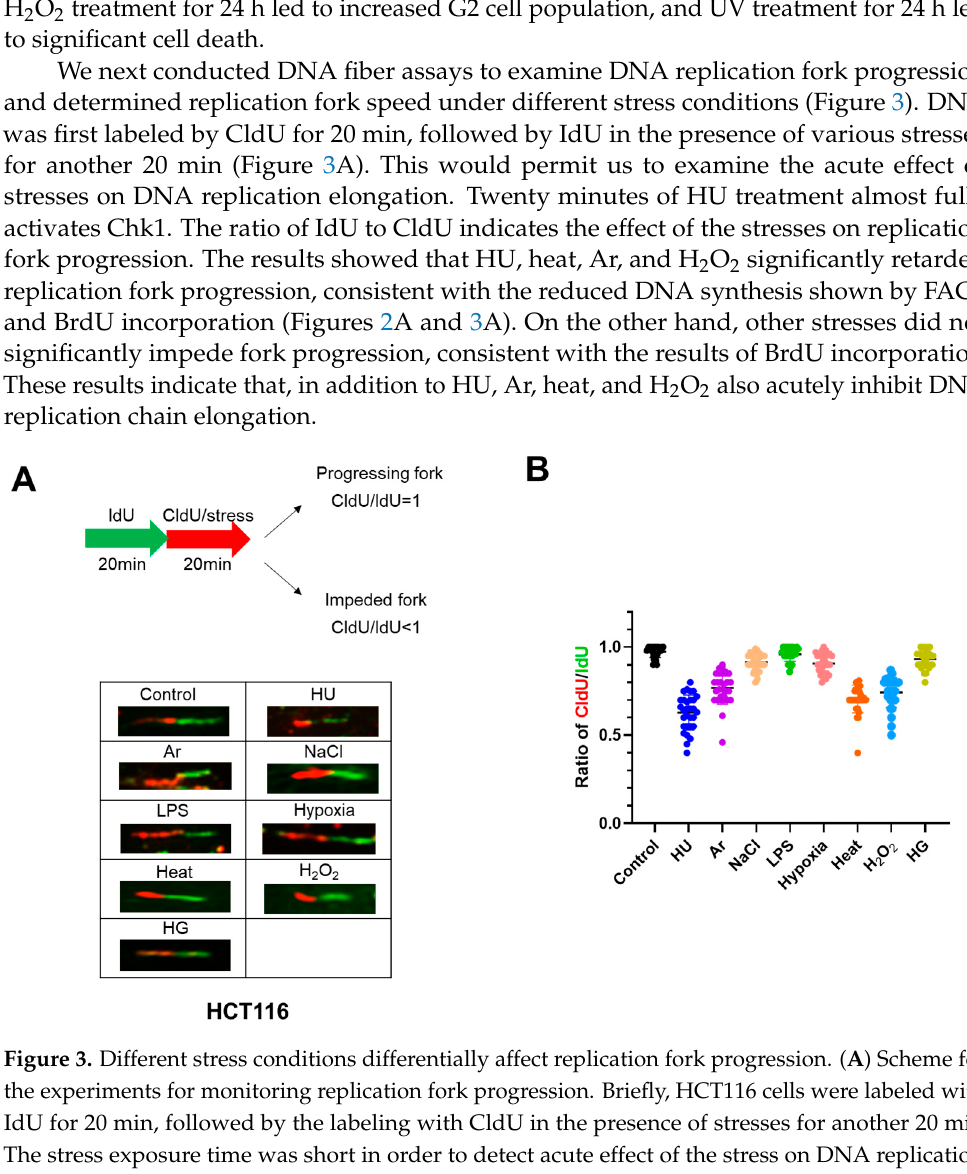
Figure 3. Different stress conditions differentially affect replication fork progression. ( A ) Scheme for the experiments for monitoring replication fork progression. Briefly, HCT116 cells were labeled with IdU for 20 min, followed by the labeling with CldU in the presence of stresses for another 20 min. The stress exposure time was short in order to detect acute effect of the stress on DNA replication. It has been known that exposure to HU for 20 min activates Chk1. The ratios of CldU/ IdU less than 1 indicate that replication fork progression is impeded by the stresses. Representative DNA fibers under different stress treatments are shown below the scheme. ( B ) The CldU/ IdU ratios in the presence of indicated stresses were determined and are presented. All statistical analyses represent the indicated mean values ± SEM under two independent